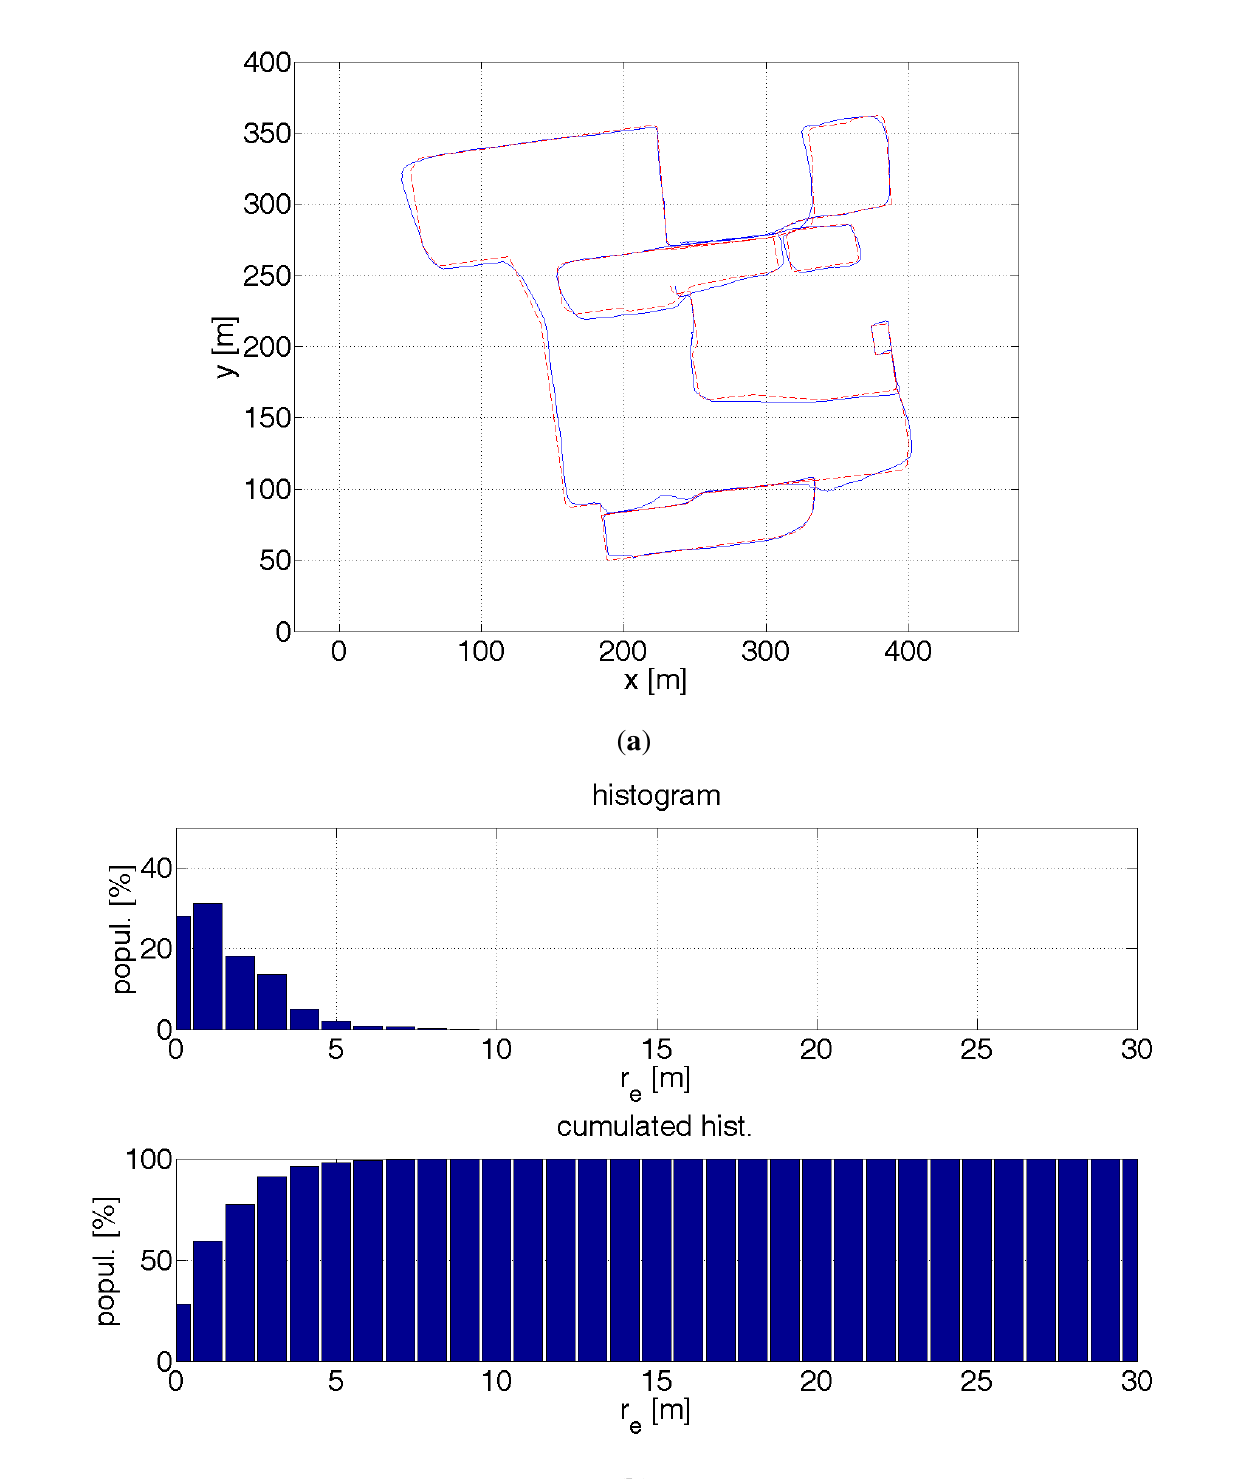
Figure 18. ( a ) Red dashed line—reference path. Blue solid line—estimated path with a help of GPS receiver, inertial sensors, probability map. The probability map eliminates direction errors, by pruning particles that diverge from a reference direction. Therefore errors are instantly eliminated and do not propagate. The positioning errors are then described by random walk with bounds. ( b ) Histograms of distance